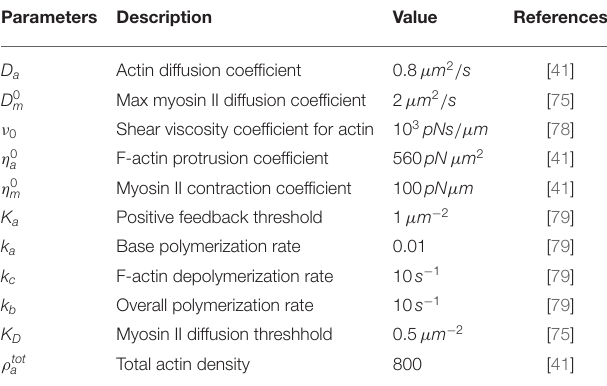
TABLE 1 | Dimensional parameters and their values as used in the model. Parameters